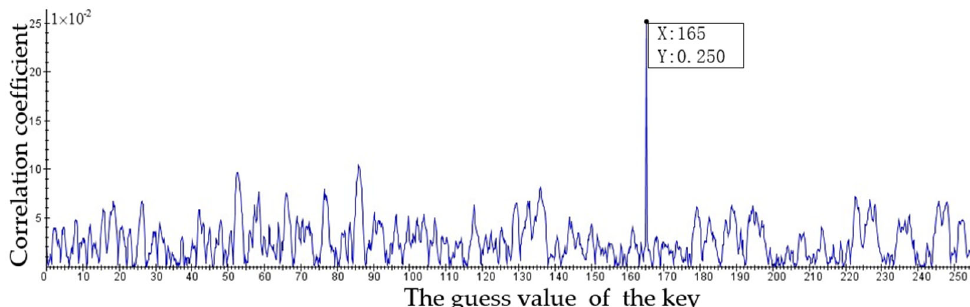
Figure 4. The first byte of 1 V CPA attack result.